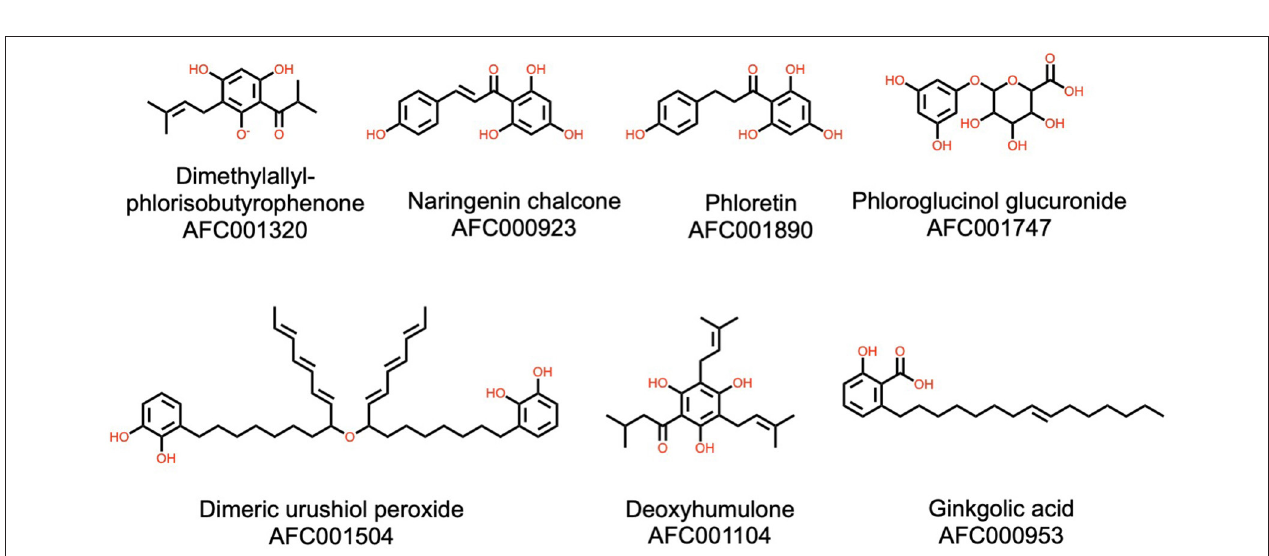
FIGURE 7 | Examples of dipeptides, tripeptides, and one non-ribosomal peptide (AFC001723) present in the watermelon. Please refer to Materials and Methods (section AFC Identifiers) for the definition of the AFC identifiers.